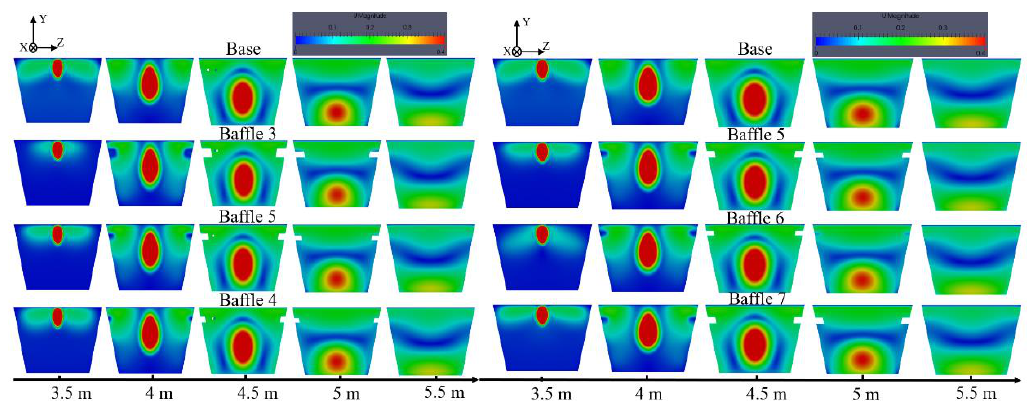
Figure 20. Effect of adding baffles with different widths ( a ) and different heights ( b ) to suppress the reflux on the velocity distribution of the main trough.